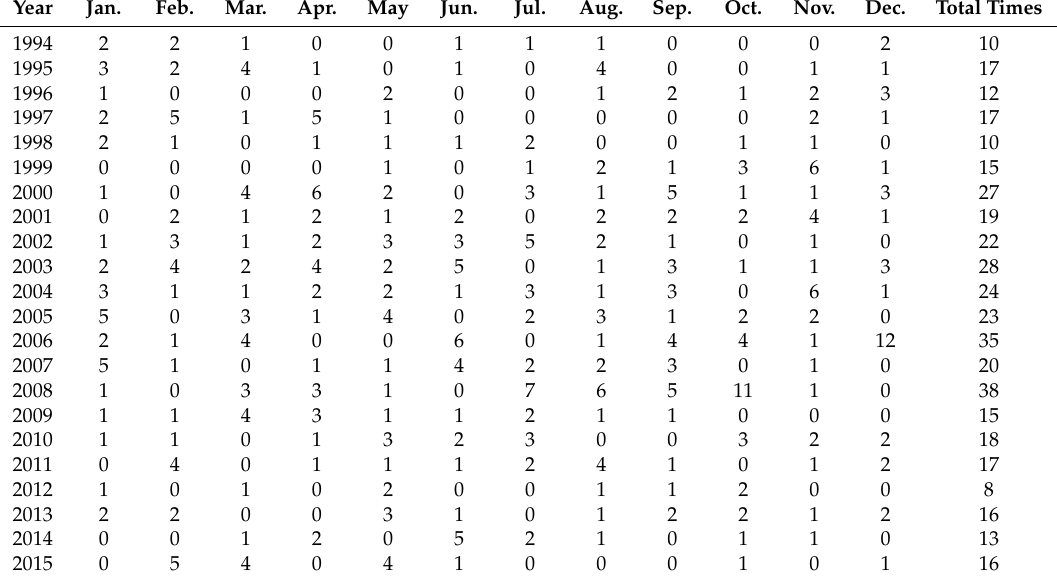
Table 6. The year selection frequency of each month to be a TMM in the period of 1994–2015. Year Jan.